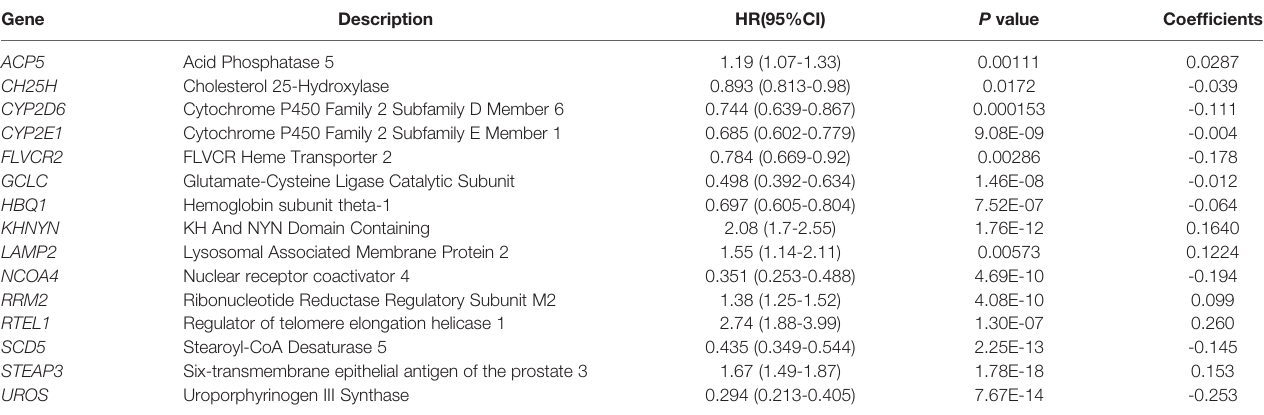
TABLE 1 | Iron metabolism-related genes and their relationship with OS, and their coef fi cients in LASSO regression model.